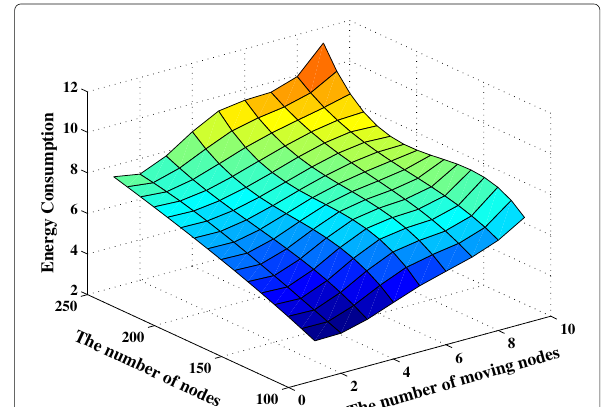
nodes, the number of moving nodes has less effect on energy consumption. And each node has similar energy consumption, thus some leaders and non-leaders can not die because of costing more energy by receiving data or sending data. Moreover, it is noticed that all energy con- sumption is less than those obtained by Algorithm 1, when the number of node is 100, the average roses on energy consumption for different number of moving nodes are 30.4, 43.8, 45.8, 56.2, and 61.6%, respectively. And com- pared with energy consumption obtained by Algorithm 2, the average roses on energy consumption are 20, 28.1, 39.6, 49.7, and 57.4%, respectively. In Algorithm 3, for the same number of moving nodes, with the number of nodes increasing, the average roses on energy consump- tion rise 6.8, 11.6, 7.1, 6.8, and 1.8%, the range is less than those of Algorithms 1 and 2. Therefore, the saving energy scheme in Algorithm 3 not only saves more energy, but ensures that each node has similar energy consumption, improving network